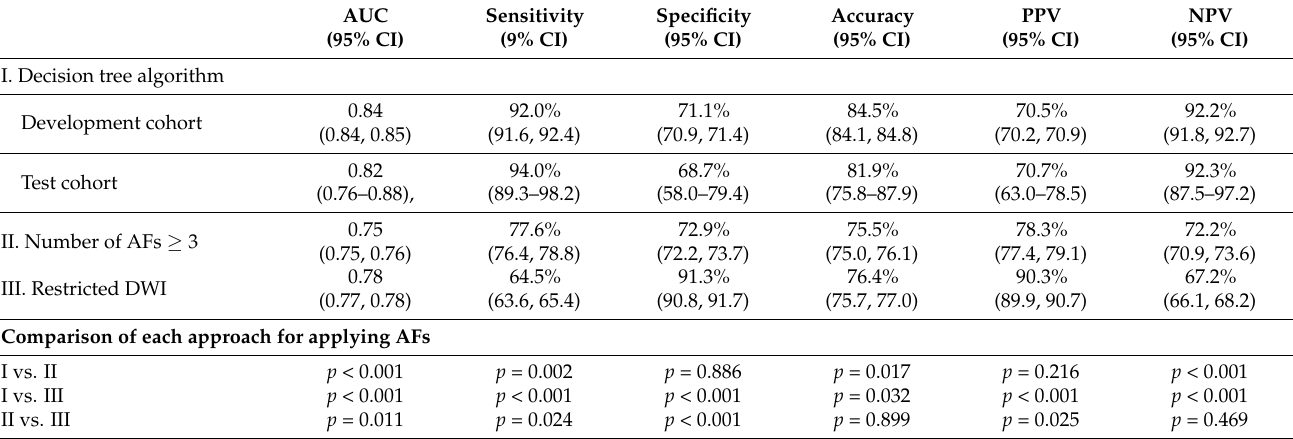
Table 4. Comparison of various approaches for applying AFs to LR3 and LR4 for diagnosis of